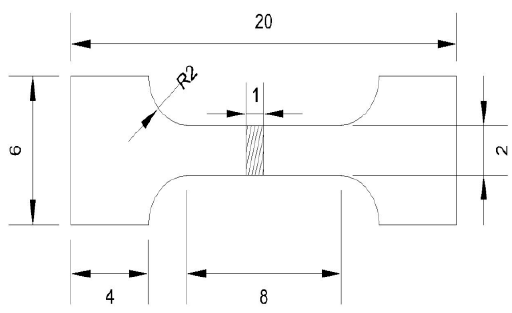
Figure 1. Equal channel angular pressing (ECAP) mold diagram. Figure 2. The dimension of the uniaxial tensile specimen (Unit: mm).